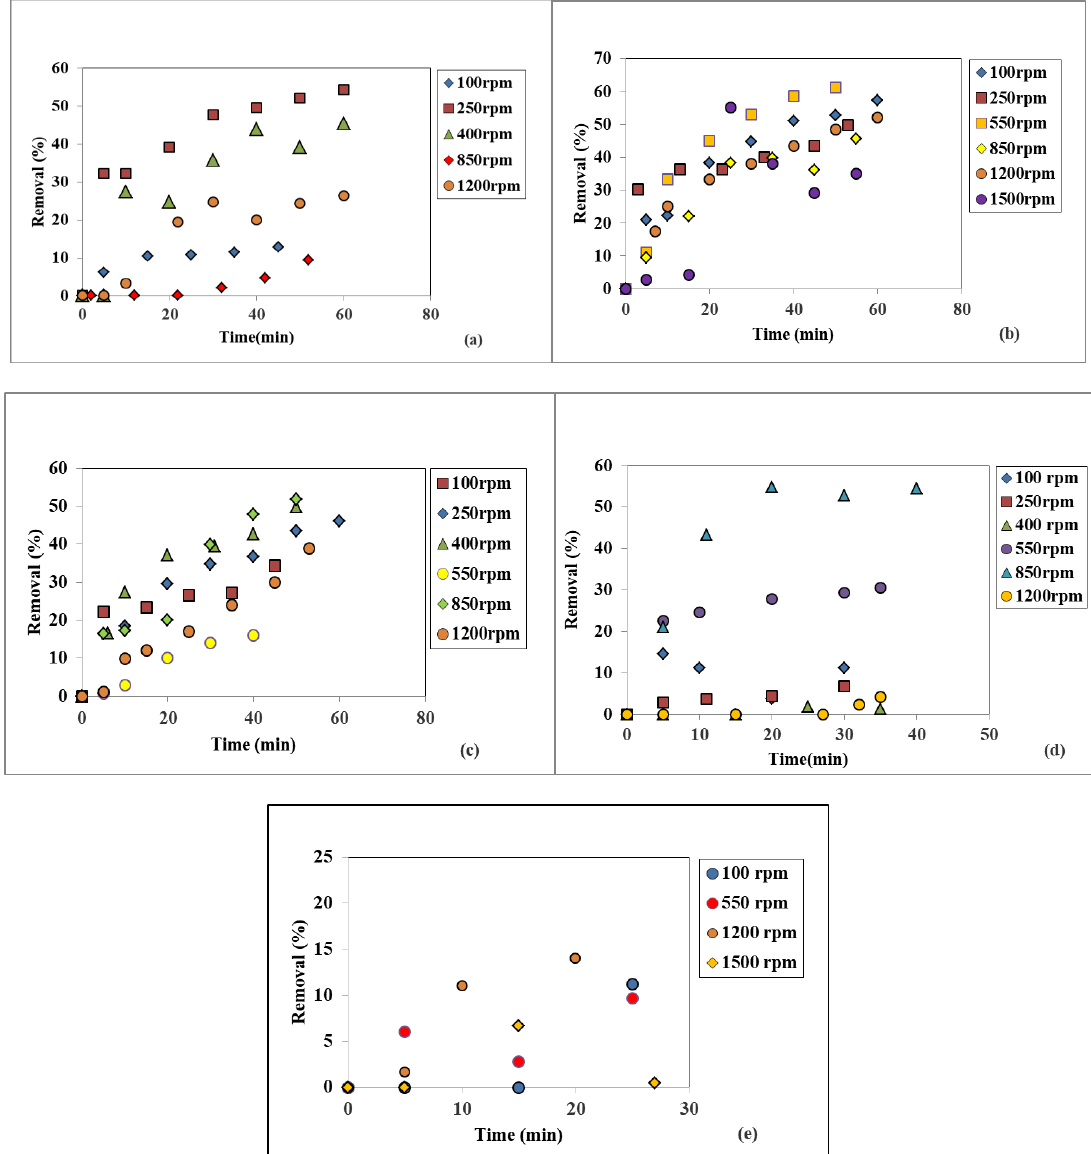
Figure 7. Influence of the disc rotational speed on the suspended solids removal at different liquid flowrates: ( a ) 10 L/h, ( b ) 15 L/h, ( c ) 20 L/h, ( d ) 25 L/h, ( e ) 30 L/h.